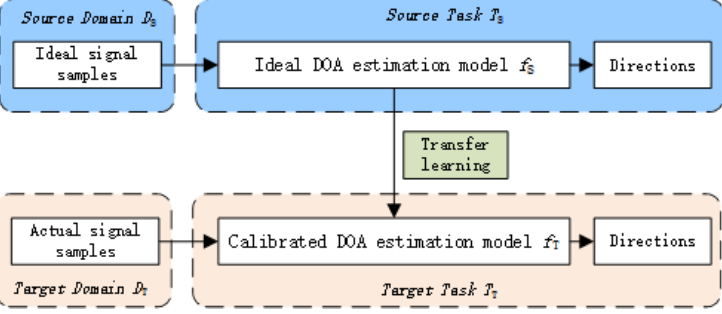
Figure 5. Overall framework of the proposed method.